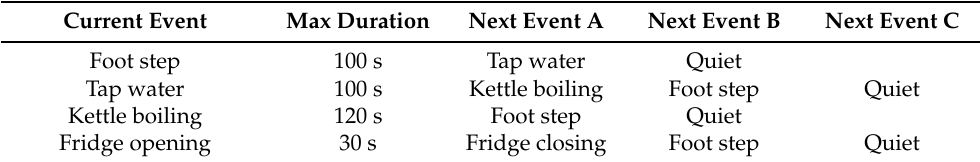
Table 3. Context data